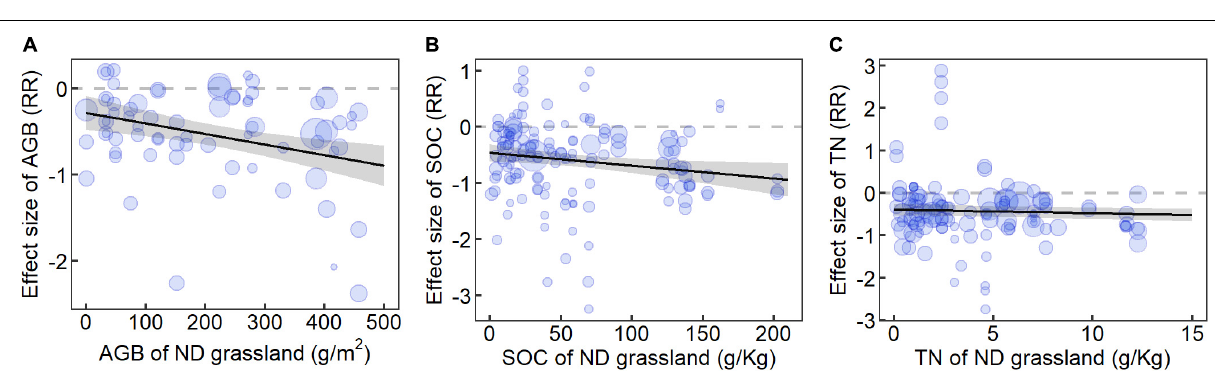
FIGURE 4 | Changes in (A) aboveground biomass, (B) soil organic carbon, and (C) soil total nitrogen with corresponding variables of non-degradation grassland. RR , response ratio. RR = 0, dashed gray line; predicted mean effect size (with 95% CI in gray), black lines. The size of data points (in blue) is proportional to the sampling variance. Results were obtained with single